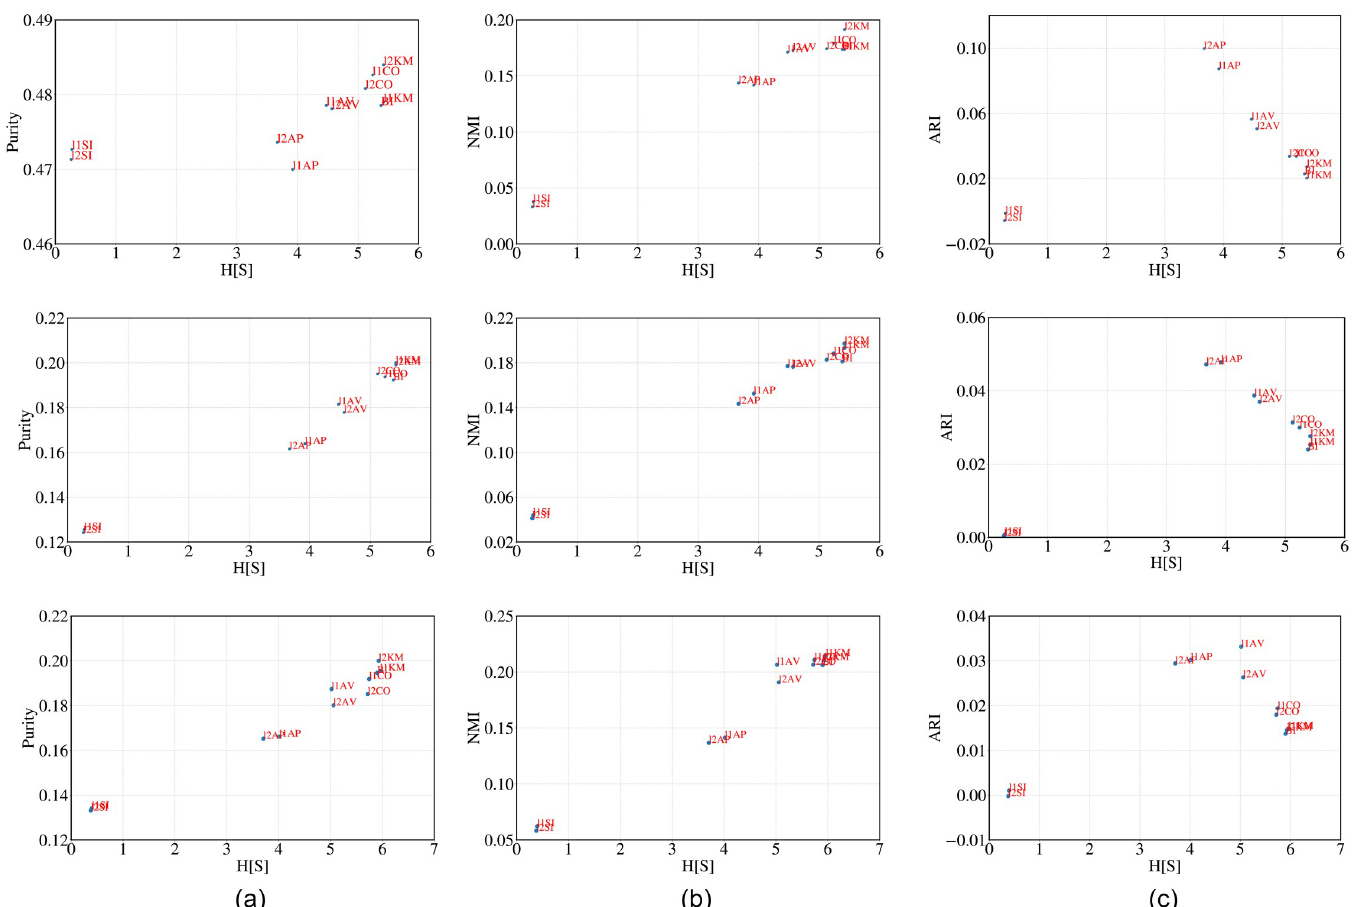
Fig 3. H[S] versus purity, NMI and ARI for (i) crime murder (top), (ii) crime robbery (middle) and (iii) crime auto (bottom). https://doi.org/10.1371/journal.pone.0239331.g003 dependence suggests that ^ H ½ s � is able to correctly rank the performance of the clustering algo- rithms. High correlation between the rankings of clustering algorithms obtained through ^ H ½ s � and majority (refer to Tables 13 (leaf) and 14 (abalone)) further supports our hypothesis.